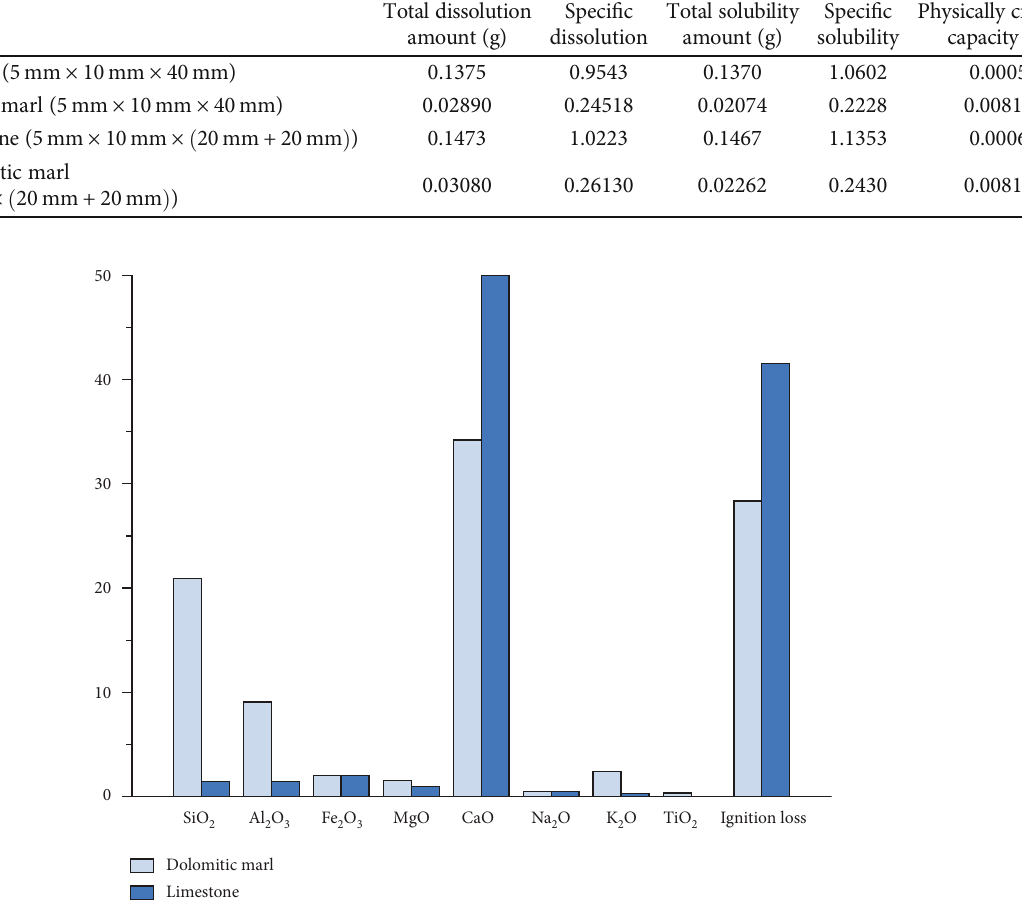
Figure 12: Chemical composition of Ordovician karst.